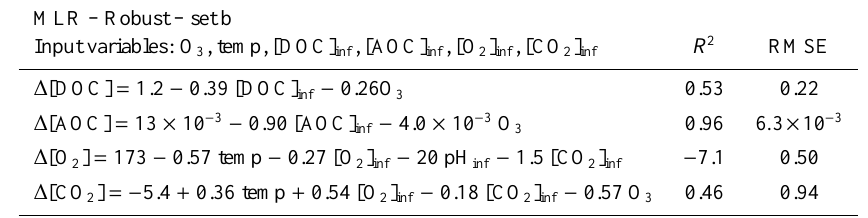
Table 4. MLRs biological conversions in (B)GAC pilot filter. MLR – Robust – set